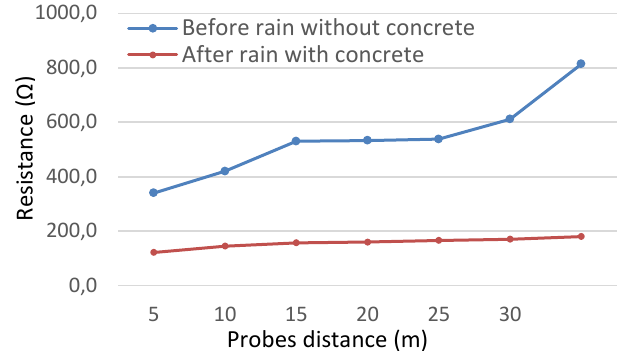
Fig. 8. Comparing ground not concretes rain and concreted after rain.